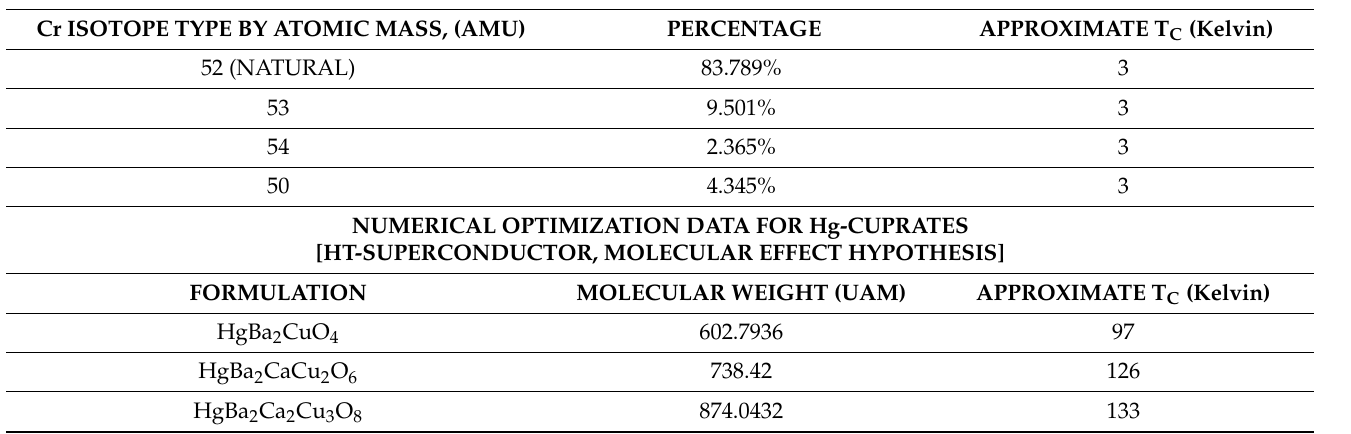
Table 1. Numerical data for Cr and HTSC